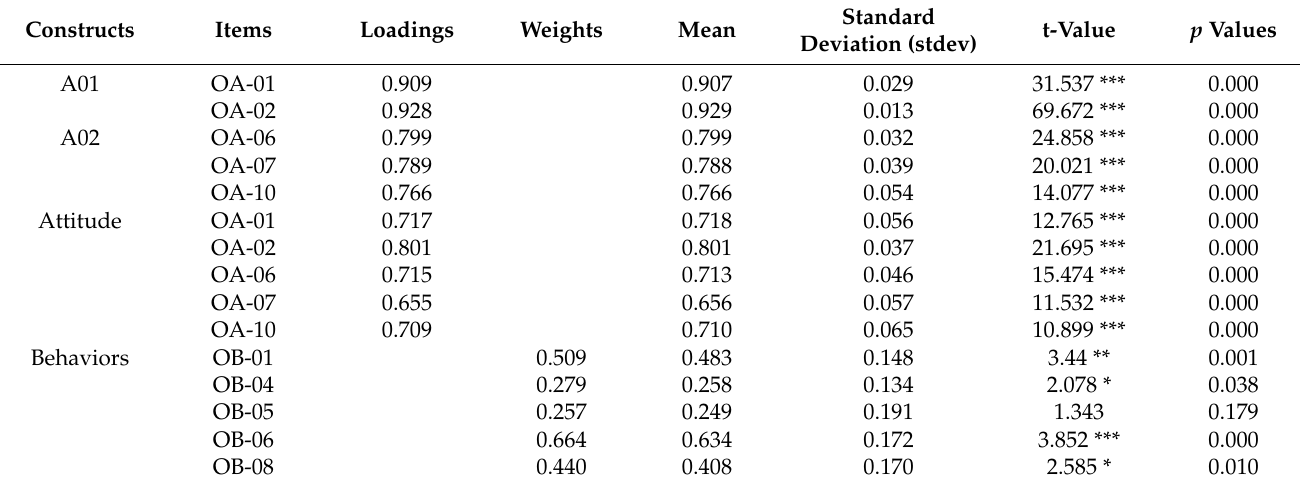
Table 5. The loadings and outer weights of all items.